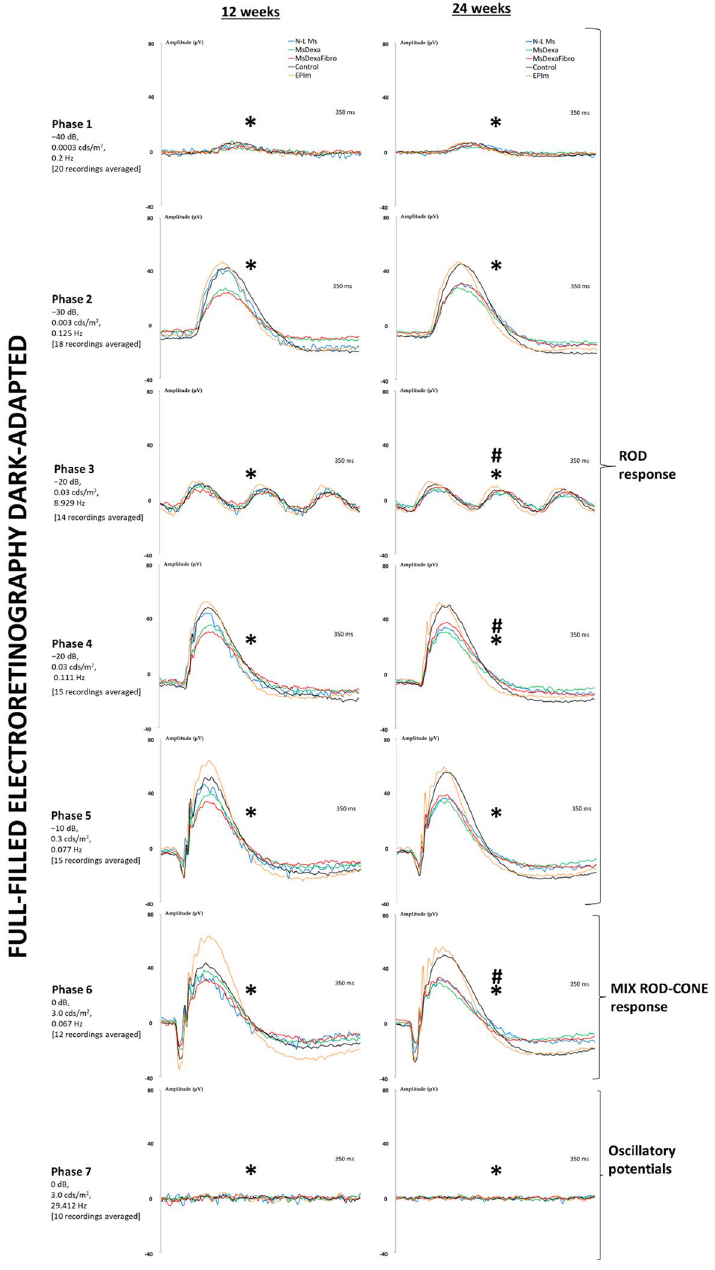
Figure 8. Follow-up comparison of neuroretinal function using dark-adapted electroretinography between four chronic glaucoma models and healthy control cohorts. Full-field ERG test. μV microvolts; ms milliseconds; dB decibel; cds: candels; m 2 square meter; Hz hertzio; N-L Ms cohort with non-loaded microspheres; MsDexa cohort with microspheres loaded with dexamethasone; MsDexaFibro cohort with microspheres loaded with dexamethasone and fibronectin; EPIm cohort with sclerosis of the episcleral veins;*: statistical significance ( p < 0.05) between glaucoma models and healthy controls (ANOVA); #: statistical significance between the episcleral vein sclerosis model and each microsphere model by Scheffé